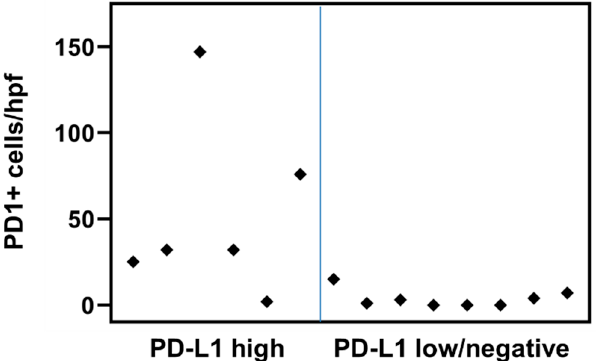
Figure 3. Comparison of the number of PD1-positive cells per high-power field between blastic plasmacytoid dendritic cell tumors with high-level PD-L1 expression (H-score ≥ 60) and those with negative/lowPD-L1 expression.